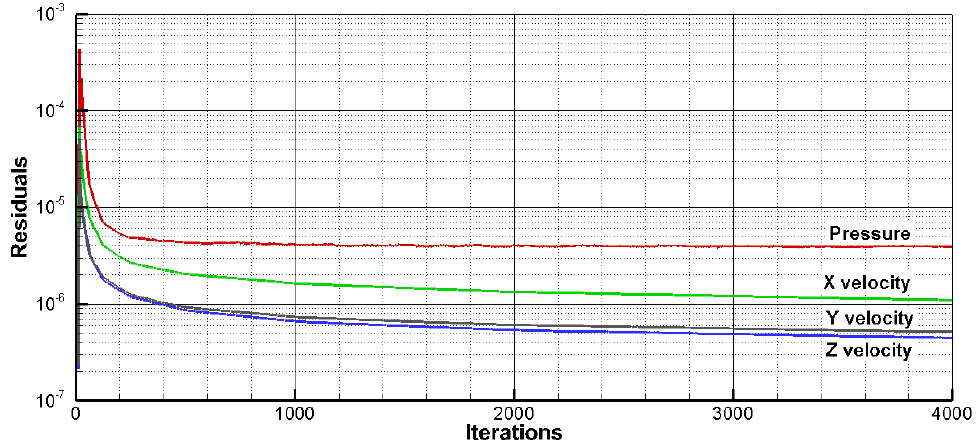
Figure 4. Residuals history for C Q = 0.685 at the maximum test section speed.